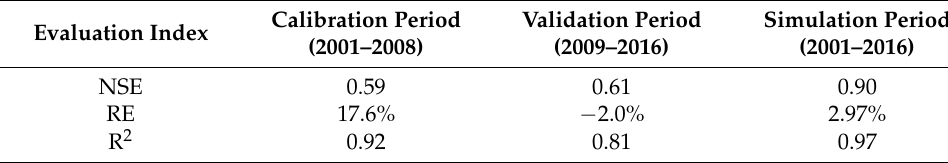
Table 3. Simulation efficiency and evaluation index in different